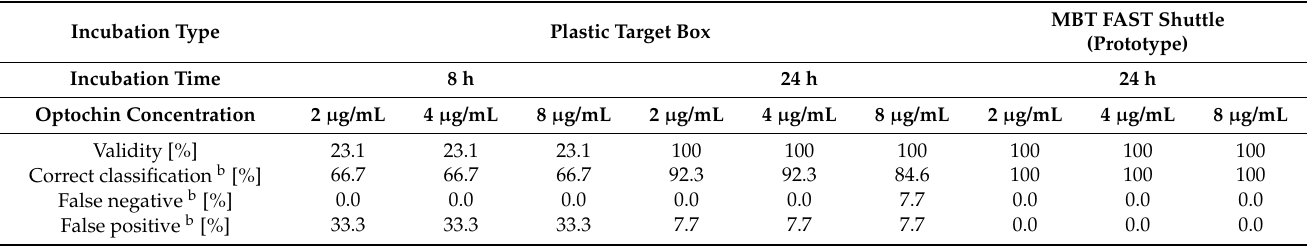
Table 1. Performance of MALDI-TOF MS-based DOT-MGA for establishing optimal test conditions for optochin susceptibility testing using evaluation with MBT FAST prototype a .